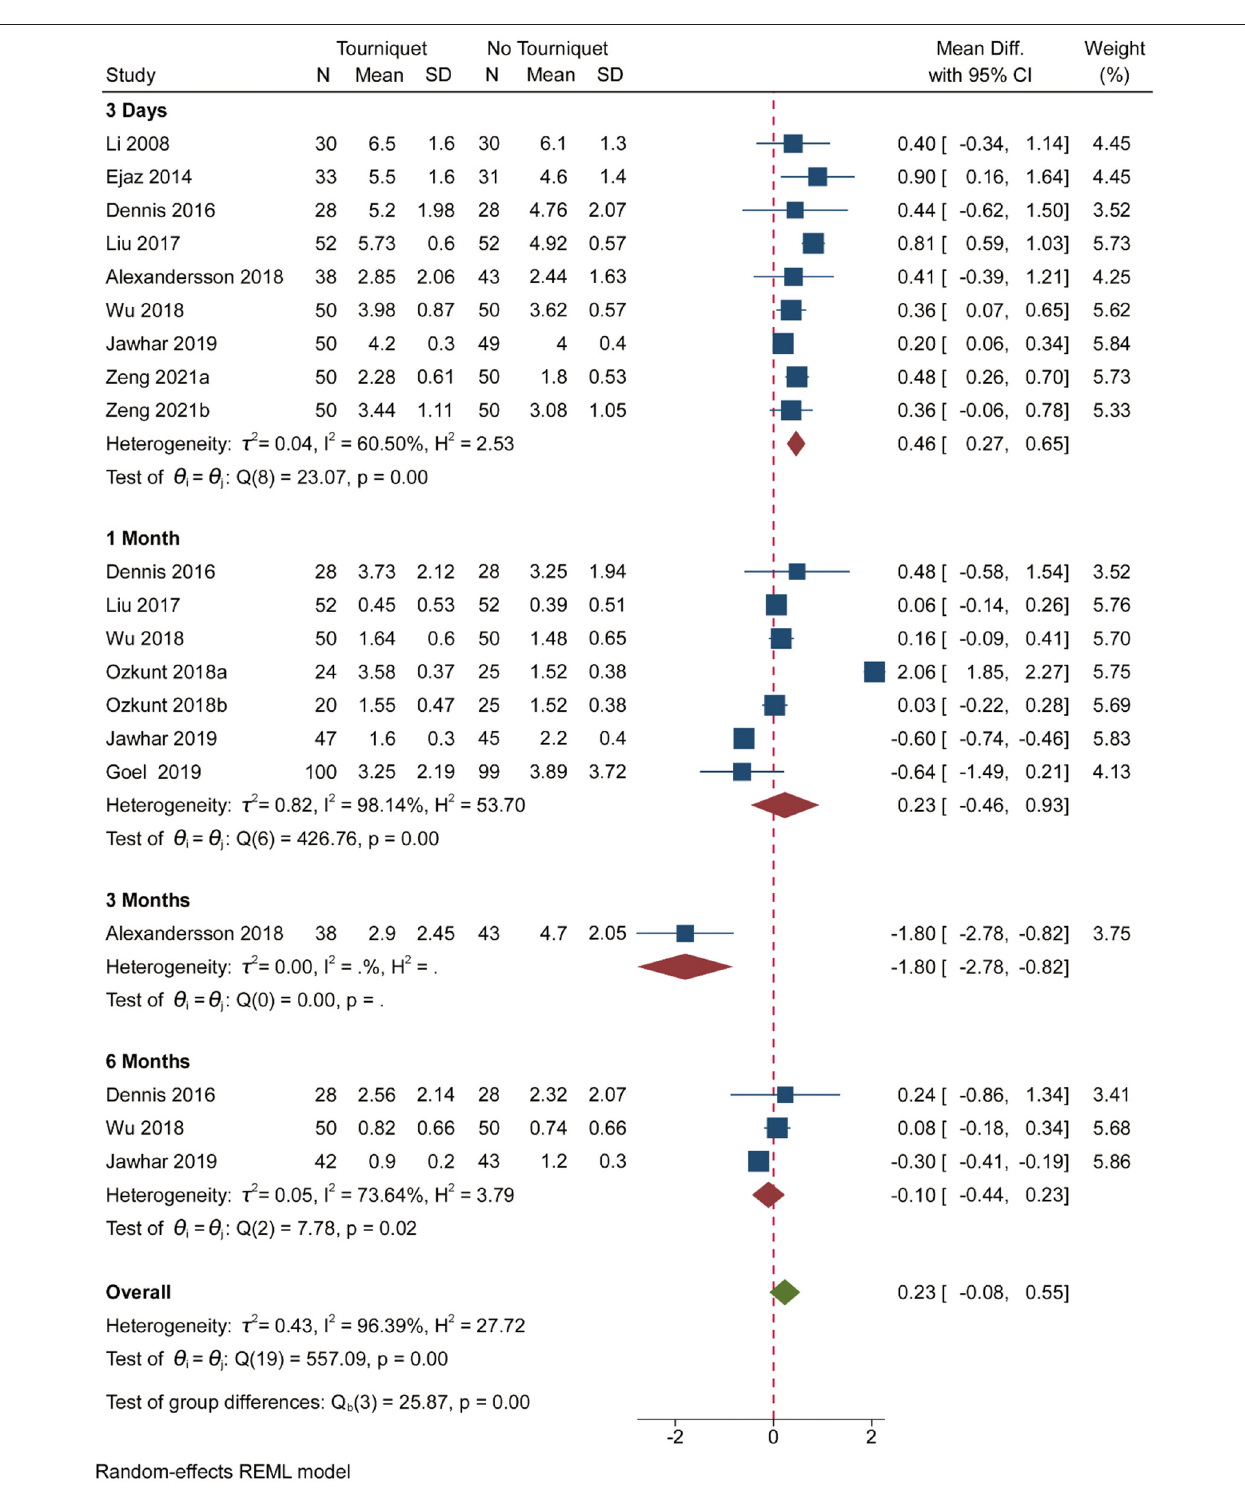
Frontiers in Public Health |